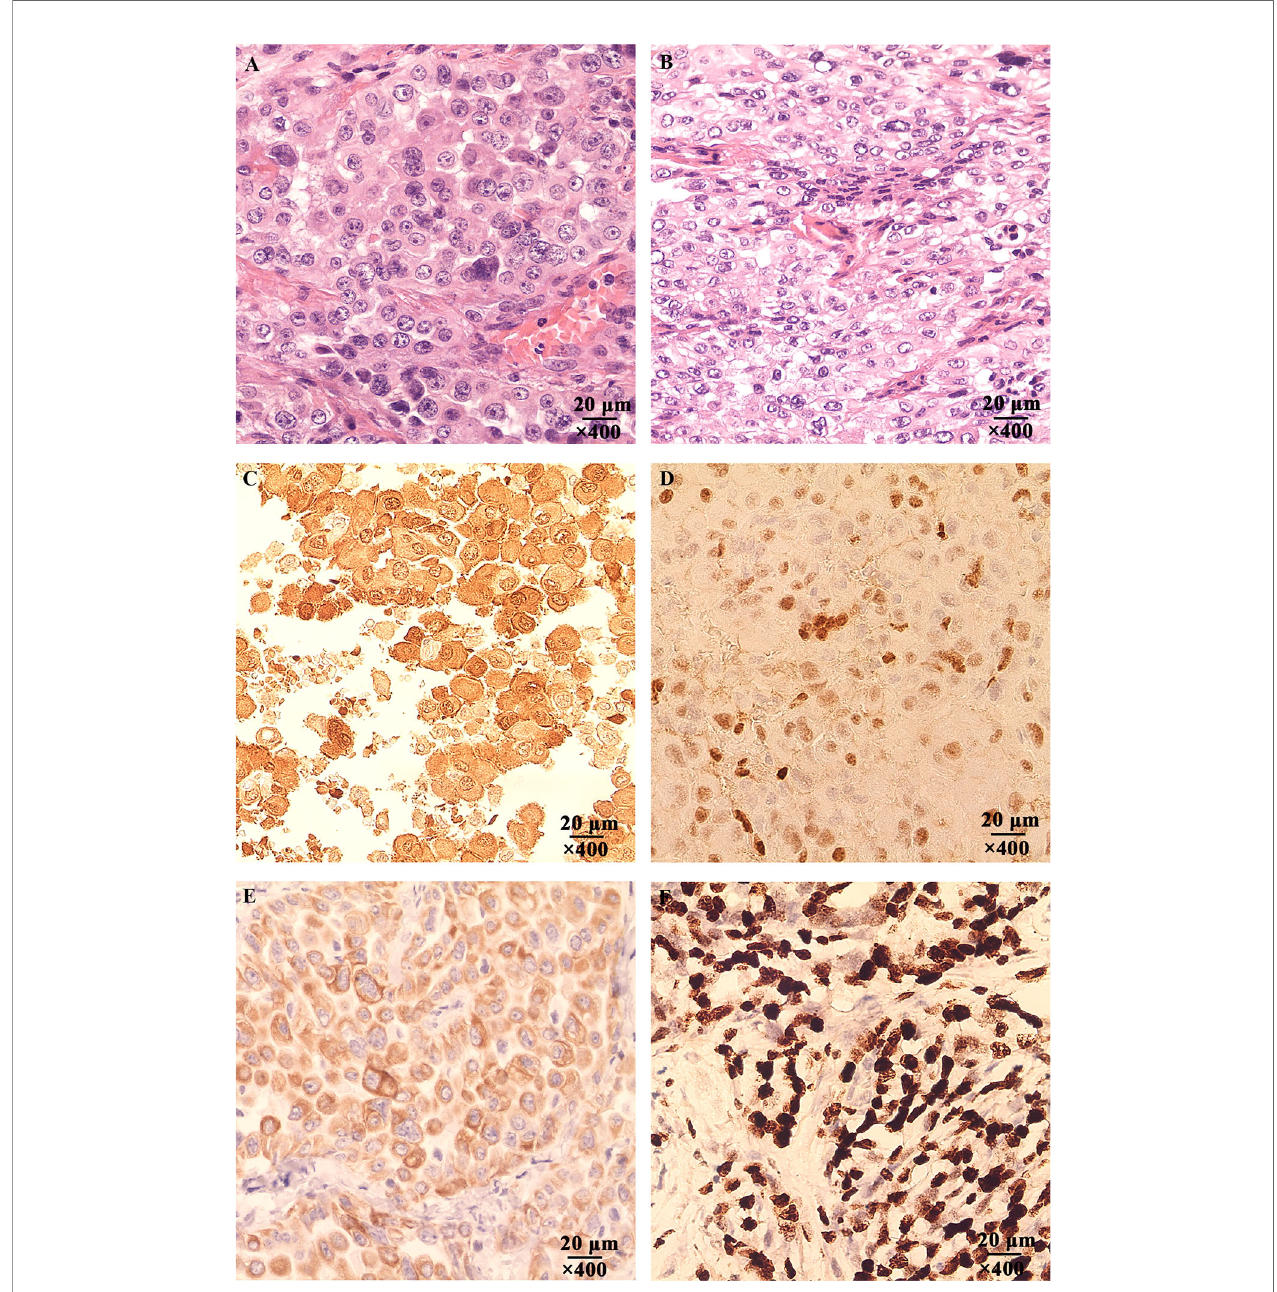
(D) The expression of WT-1 was positive, magni fi cation, ×400. (E) The expression of Cytokeratin 5/6 was positive, magni fi cation, ×400. (F) The expression of Ki-67 was positive, magni fi cation,